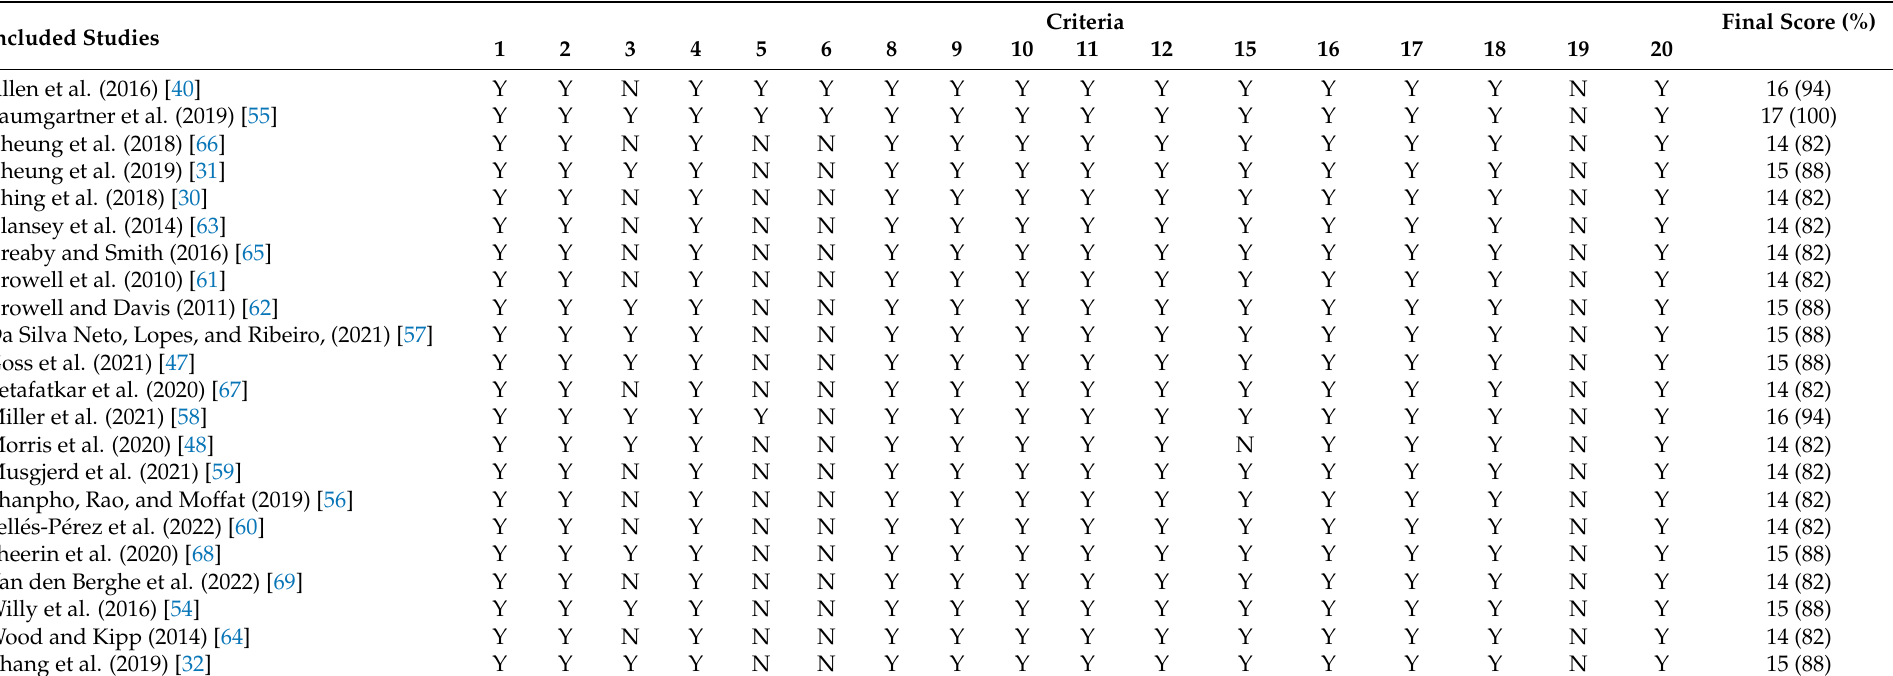
Table 1. Assessment of methodological quality using the AXIS scale. Y = criterion met, N = criterion not met. Final score = sum of Ys and Ns in the case of criterion 19 (with the percentage value in parentheses). Some criteria were excluded from the analysis because they were not related to the studies evaluated (criteria 7, 13, and 14); therefore, 17 criteria contributed to the final